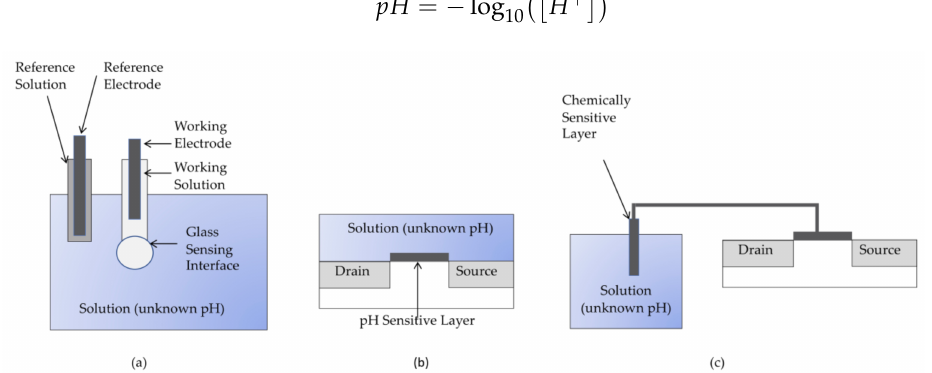
Figure 5. Electrochemical pH Sensors. ( a ) Traditional, glass electrode-based pH sensing; ( b ) ISFET- based pH sensing, where the gate of a field effect transistor (FET) is removed and is replaced by the interaction of solution and pH-sensitive layer to modulate the current between the drain and source of the transistor; and ( c ) extended gate FET (EGFET), which separates the electronic half of the ISFET from the electrochemically sensitive half in order to extend sensor lifetime and reduce